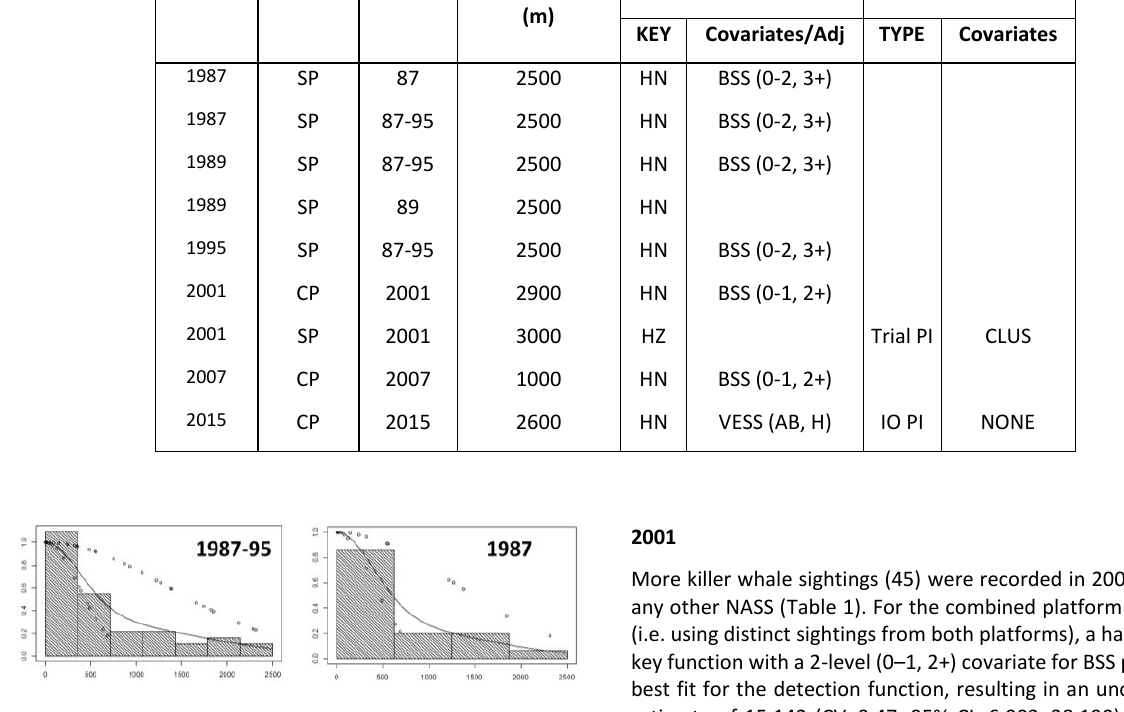
Table 2. Model specifications. MODE - platform configuration; SP - single platform; CP - combined platforms; HN - half normal; HZ - hazard rate; BSS - Beaufort Sea state; VESS - vessel identity; CLUS - cluster size.